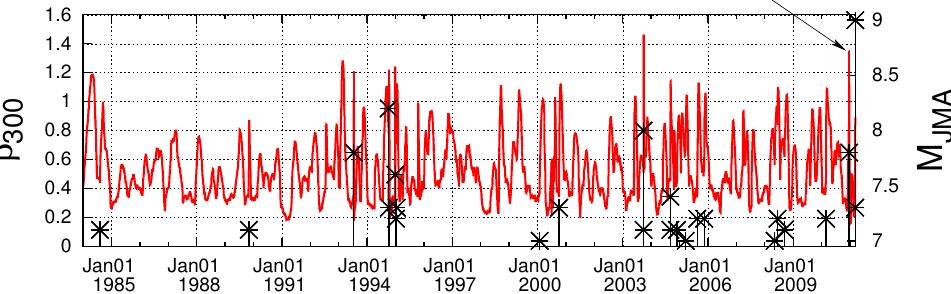
Figure 11. The fluctuations β 300 of the order parameter of seismicity plotted versus the conventional time for i = 300 events from 1 January 1984 until the M 9 Tohoku EQ occurrence on 11 March 2011. All the shallow EQs with M ≥ 7.0 are shown (right scale) with vertical bars ending at black asterisks. The precursory increase on 22 December 2010 discussed in the text is shown with an arrow. The descriptive statistics of β 300 are presented in Figure 3f of Ref. [72] where one can read that the mean value is 0.55 while the standard deviation being 0.23. In view of the fact that the maximum value of the increase attained on 22 December 2010 is around 1.35, we find that this maximum corresponds to a fluctuation of around 3.5 standard deviations. Taken from Ref.